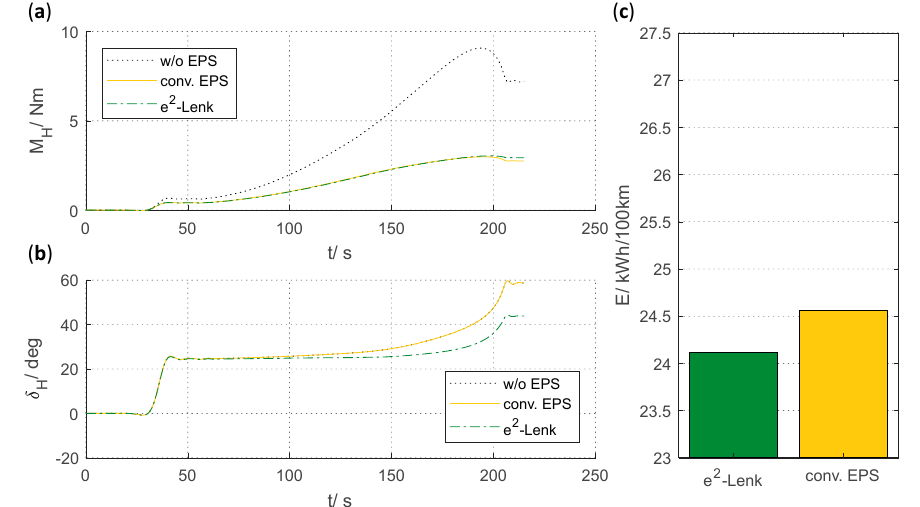
Figure 6. Quasi ‐ steady ‐ state circular operation: ( a ) dynamic response of steering wheel torque, ( b ) dynamic response of steering wheel angle and ( c ) comparison of each suspension with a conventional EPS regarding energy.